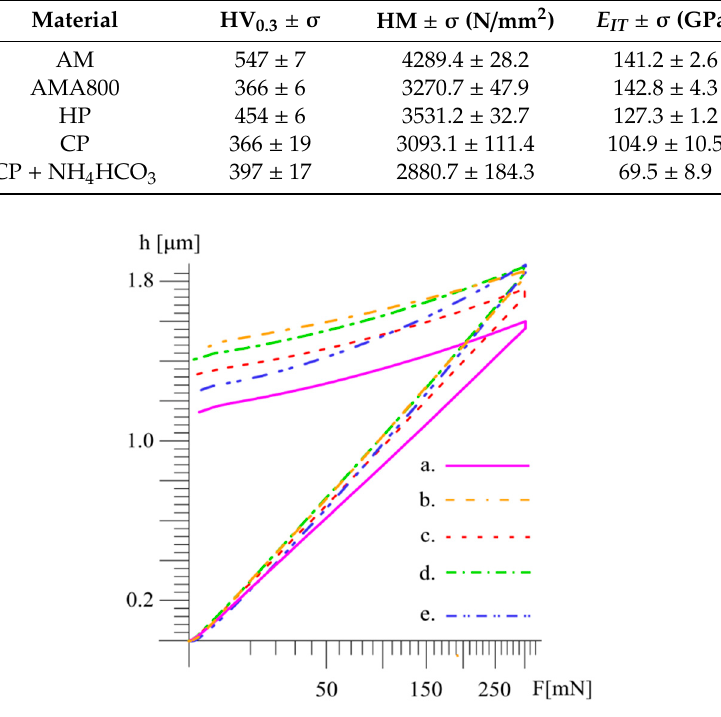
Figure 4. Depth-load (h-F) nanoindentation curves of Ti23Mo alloys obtained by different processing approaches: Arc melted ( a ), arc melted and annealed at 800 ◦ C / 24 h ( b ), MA for 48 h and hot pressed at approaches: Arc melted ( a ), arc melted and annealed at 800 °C/24 h ( b ), MA for 48 h and hot pressed 800 ◦ C / 5 min ( c ), cold-pressed and sintered at 800 ◦ C / 0.5 h ( d ) and cold-pressed with NH 4 HCO 3 and at 800 °C/5 min ( c ), cold-pressed and sintered at 800 °C/0.5 h ( d ) and cold-pressed with NH 4 HCO 3 and sintered at 1150 ◦ C / 10 h ( e sintered at 1150 °C/10 h ( e ).